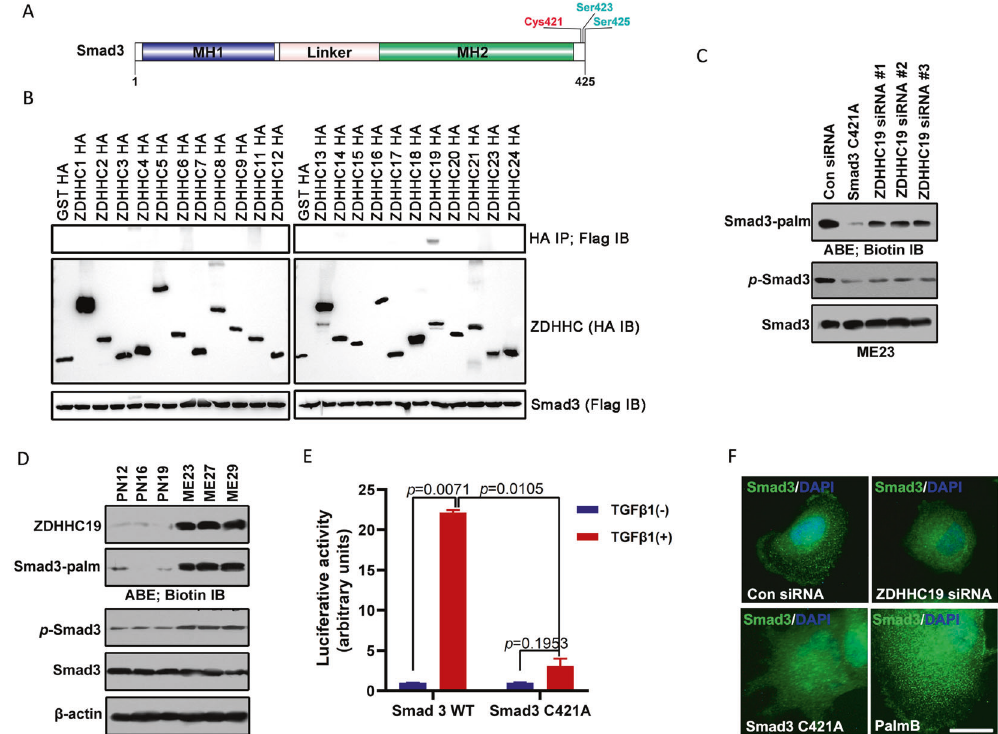
Fig. 3 Palmitoylation of Smad3 mediated by ZDHHC19 promotes its association with the plasma membrane and activation of the TGF- β pathway. A Diagram showing the sites of palmitoylation of Smad3. CSS-Palm 4.0 software indicated that Cys421 was a potential palmitoylation site for Smad3. B HEK293 cells were co-transfected with constructs encoding Flag-Smad3 and HA-ZDHHCs in a 6-well plate. Cell lysates were harvested for immunoprecipitation by anti-Flag antibody and then for acyl – biotin exchange (ABE) and western blot analysis. The results of immunoblotting for total Smad3 and HA-ZDHHC proteins are shown. C Palmitoylation and phosphorylation of Smad3 in ME23 cells transfected with Smad3 C421A mutant constructs or infected with ZDHHC19 siRNA for 48 h. D Expression levels of ZDHHC19 and Smad3 and palmitoylation level of Smad3 in proneural and mesenchymal GSCs. E The Smad3 palmitoylation mutant suppressed activation of the TGF- β / Smad-signaling pathway. ME23 cells were stably transfected with (SBE) 4 -luc, which can be activated by TGF- β 1. These ME23 cells were then transfected with Smad3 or Smad3 C421A and stimulated with 5 ng/ml TGF- β 1 for 18 h starting 24 h after transfection. F Expression of Smad3 in ME23 GSCs (monolayer culture) transfected with ZDHHC19 siRNA or Smad3 C421A mutant plasmid or treated with the de-palmitoylation inhibitor, PalmB (1 μ M) for 48 h was analyzed by immuno fl uorescence staining. Scale bar, 100 μ m. GSCs glioblastoma stem